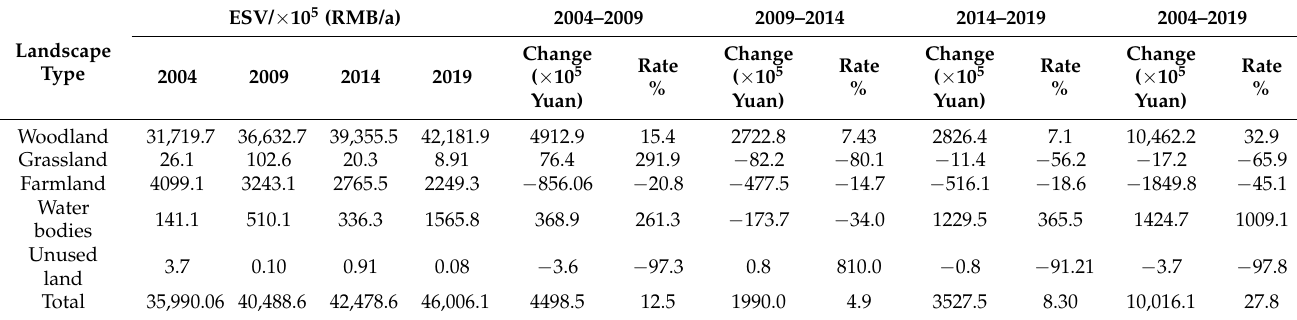
Table 9. Value and change of ecosystem services in the landscape types from 2004 to 2019.